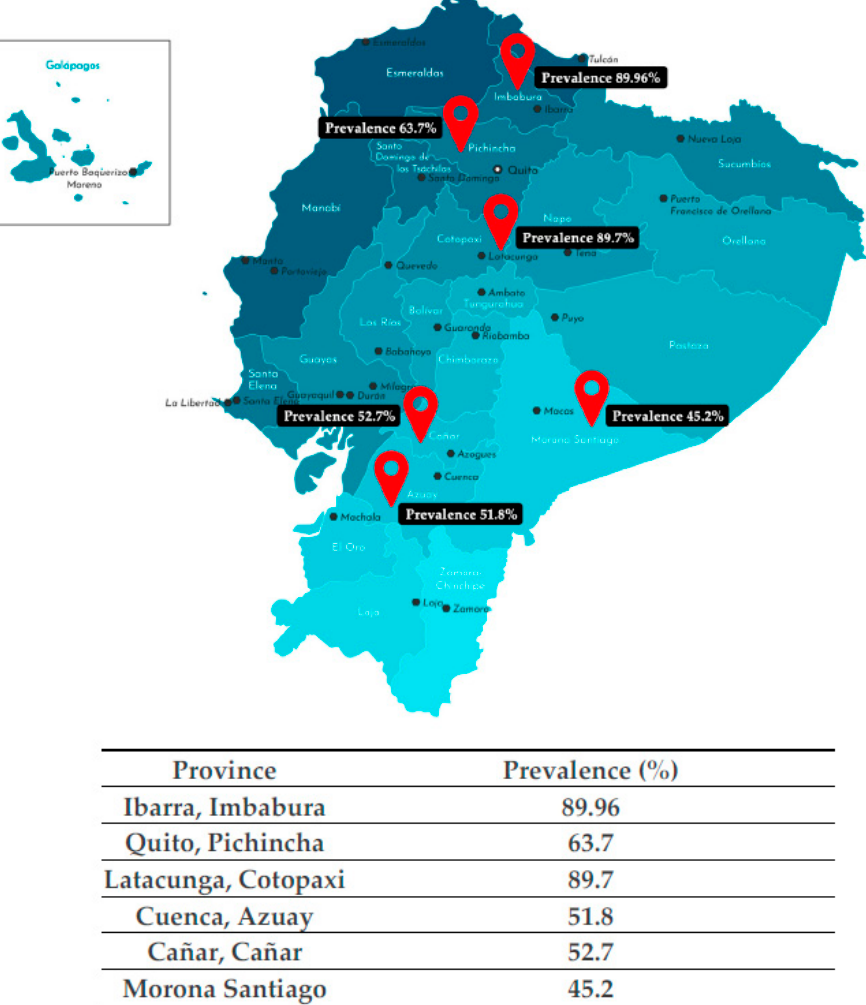
Figure 2. Geographical distribution of the areas studied and comparison with other studies. Source: Image taken from iStock. https://www.istockphoto.com/es/vector/ilustraci%C3%B3n-aislada-vectorial-mapa-administrativo-simplificado-de-ecuador-en-gm1217481314-355406824, accessed on 20 October 2022.